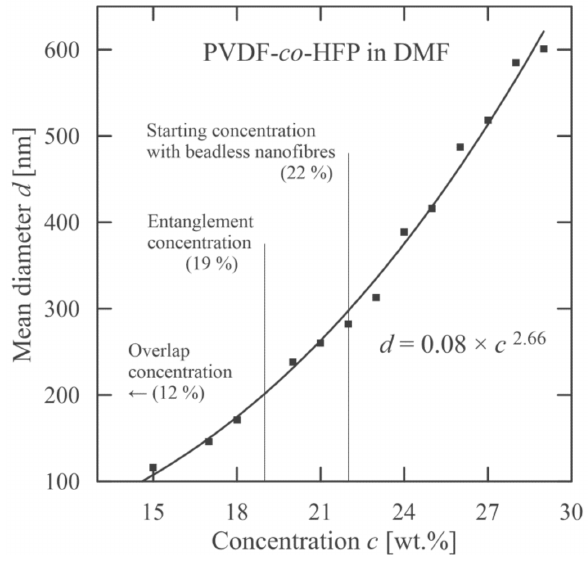
Figure 8. Dependence of mean nanofiber diameter on PVDF- co -HFP